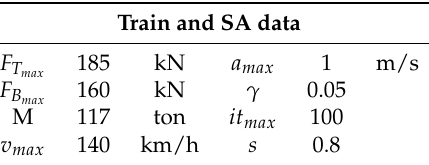
Table 5. TMS, OSP and SA Data.